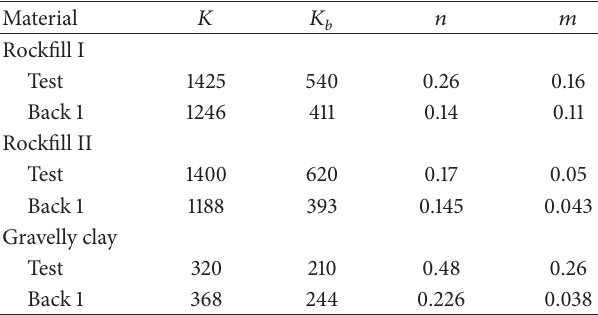
Table 2: Main E-B model parameters of main dam materials.